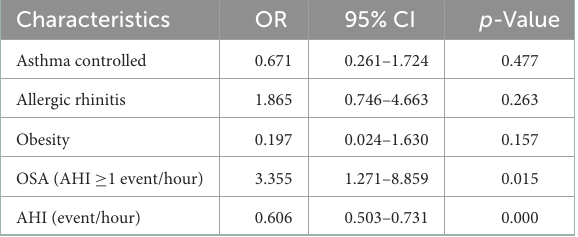
TABLE 6 Odds ratio of ADHD for study subjects.